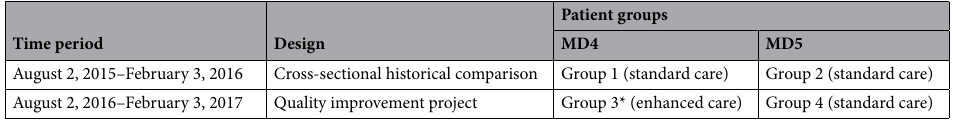
Table 1. Time period, design, and patient groups. *Designates treatment group who received enhanced model of care including PT tracking functional status and mobility